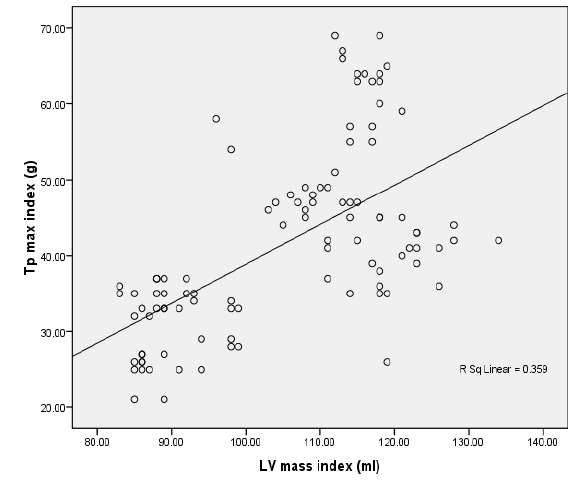
(Table 3) :pearson correlations of LV Systolic dyssynchrony with Age and BSA